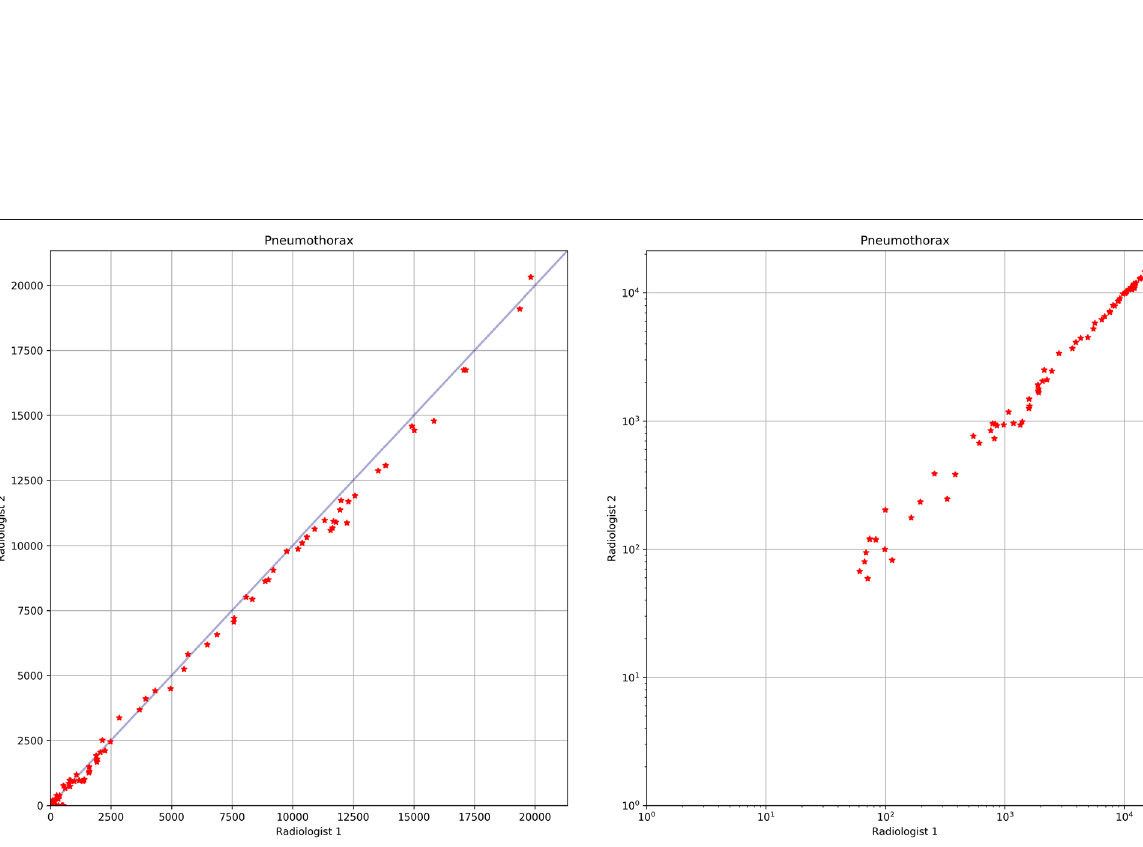
Fig. 7 Correlation of slice-wise accumulated pneumothorax areas based on pixel-level pneumothorax annotations independently performed by two radiologists. Linear scale (left) and log-log scale